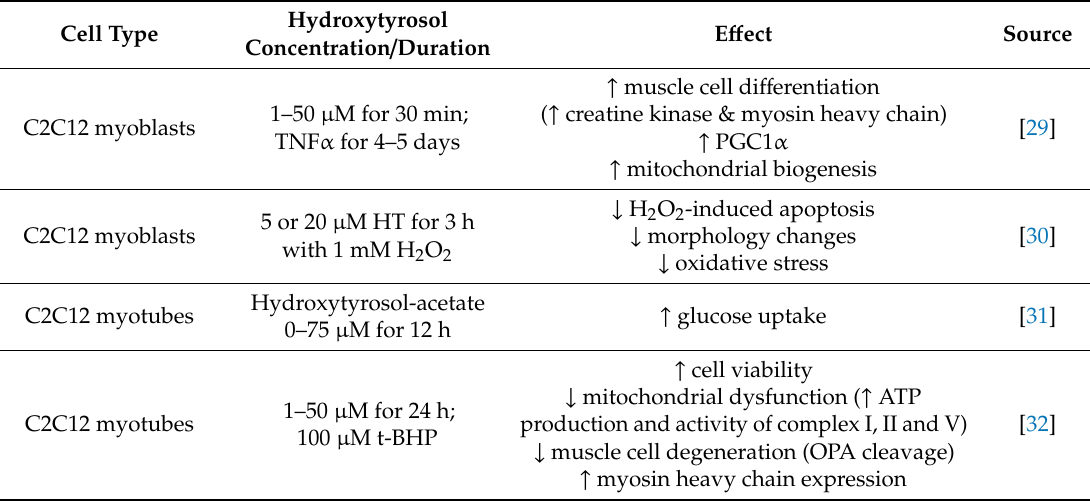
Table 3. E ff ects of hydroxytyrosol on skeletal muscle